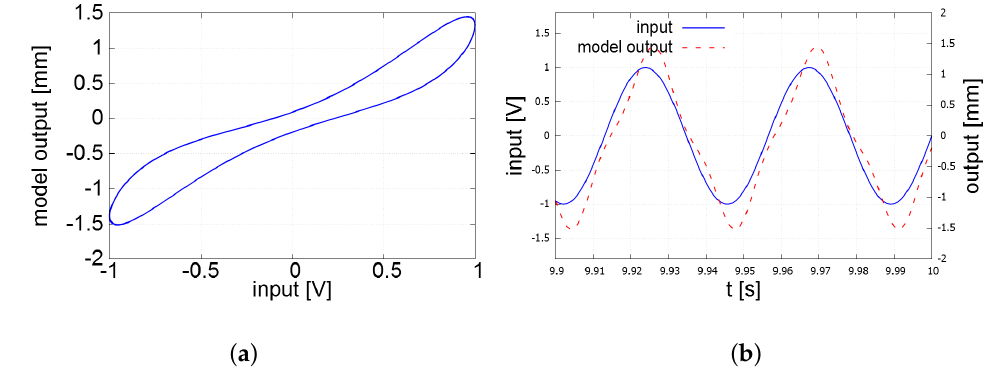
Figure 8. An example of the numerical response of the third-order harmonic hysteresis model (6) to 23 Hz sinusoidal input. ( a ) Hysteresis loop in the input/output plane; ( b ) Its time domain